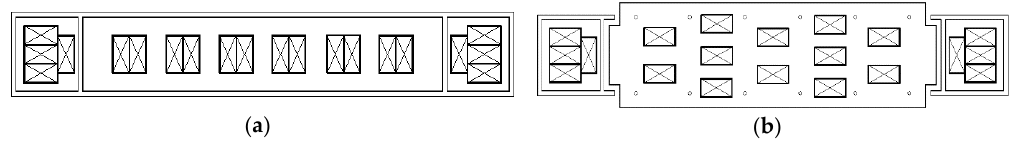
Figure 5. The weight scheme of the test model. ( a ) The weight scheme of the primary structure; ( b ) the weight scheme of suspended floors.